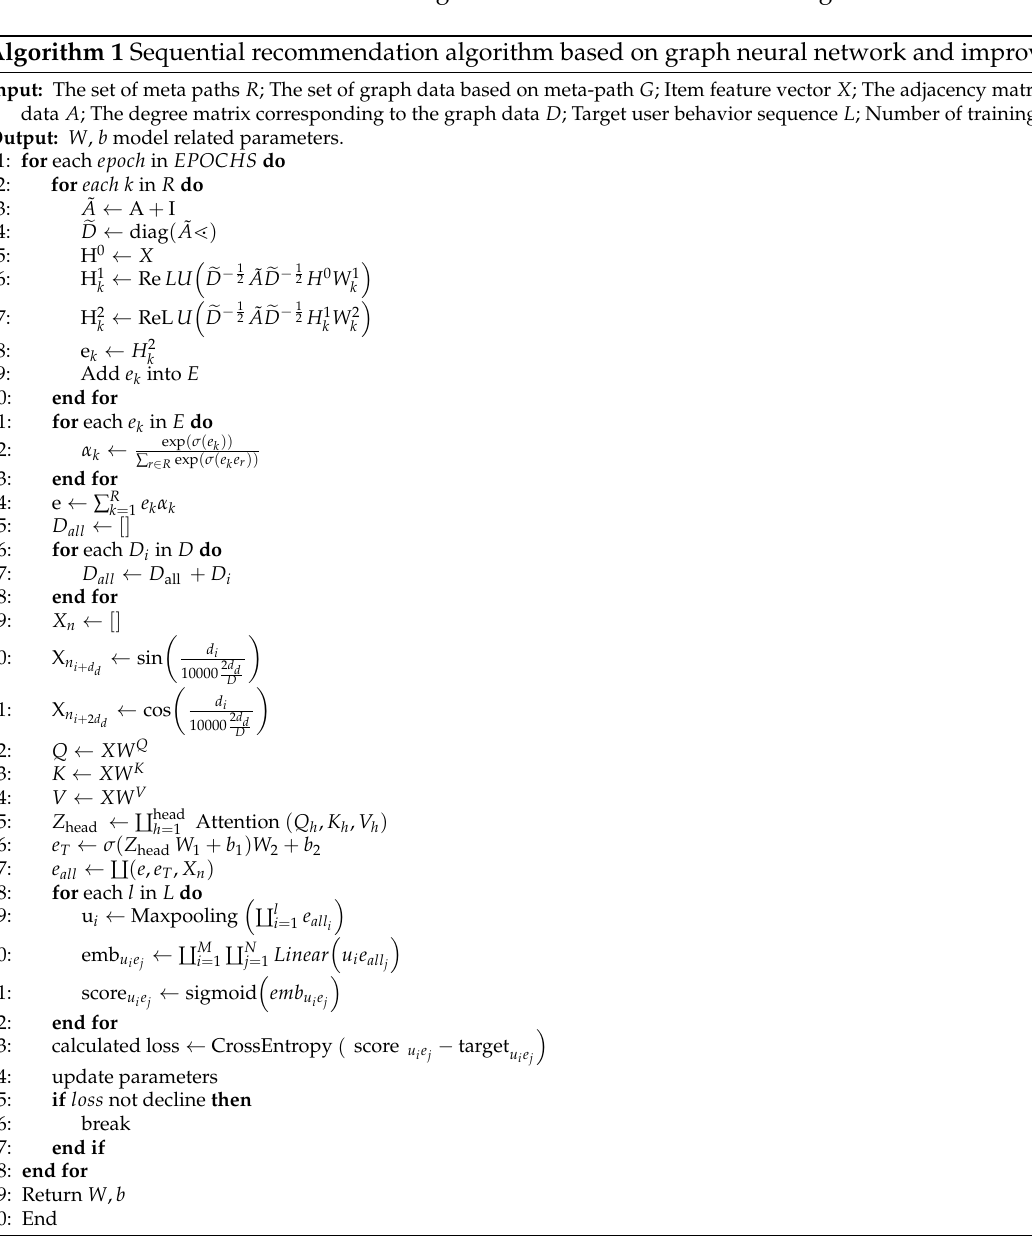
Algorithm 1 Sequential recommendation algorithm based on graph neural network and improved